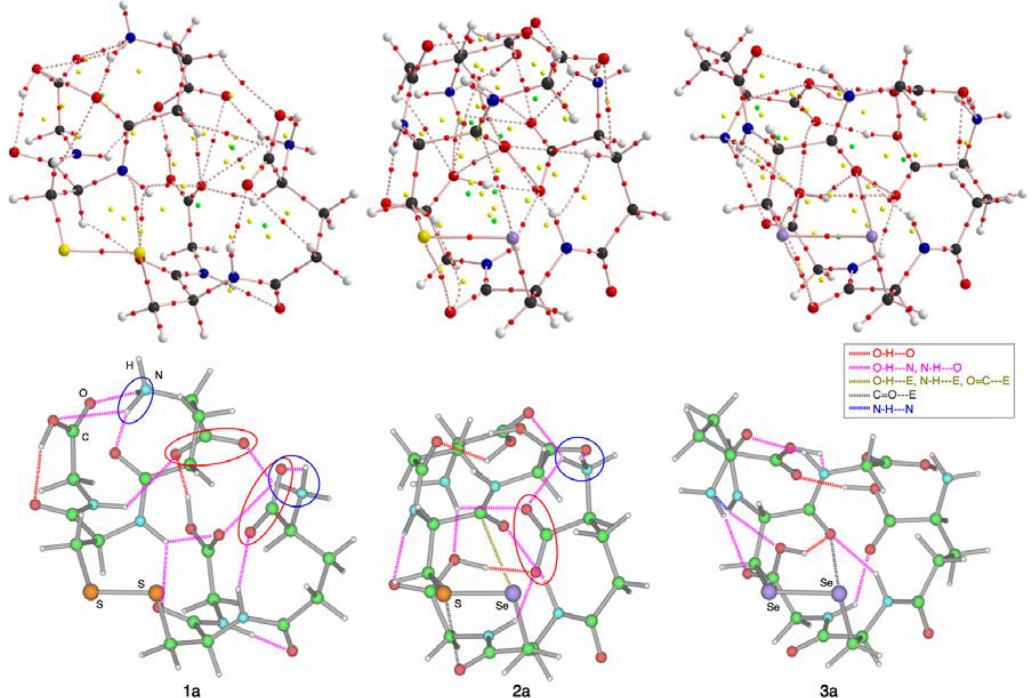
Figure 3. Molecular graphs of 1a , 2a and 3a , drawn on the optimized structures (top) and the intramolecular non-covalent interactions, corresponding to BPs in the molecular graphs, drawn on the optimized structures. The red and blue circles show the zwitter ionic –NH 3+ and –COO − moieties, respectively (bottom). The energies of 1a , 2a and 3a are employed as the standards for 1a – 1e , 2a – 2e and 3a – 3e , respectively.